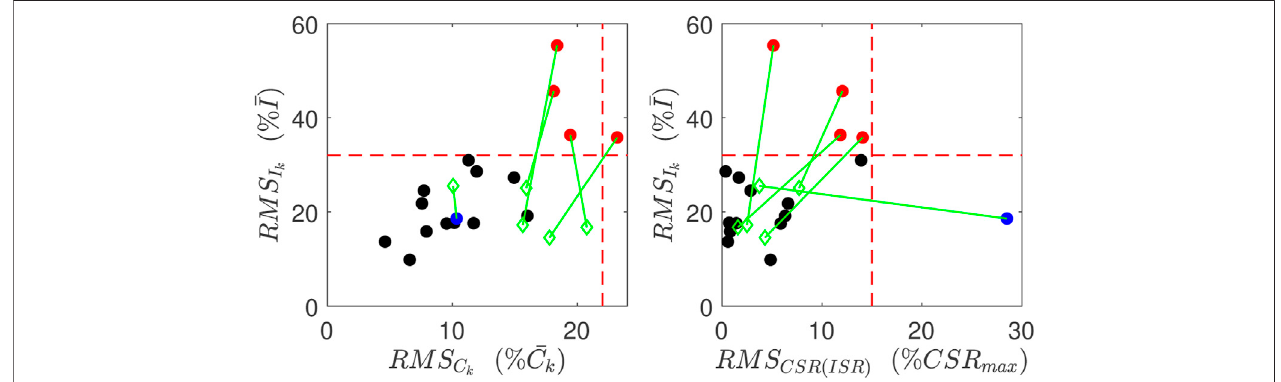
FIGURE5| Goodness ofFitsfor normal subjects.Red points indicate have relatively poorreconstruction ofinsulin measurements,and theblue point has relatively poor linear relation between CSR and ISR. These metrics for these poor reconstructions are all improved (green points) when the data point at 60 min is left out.